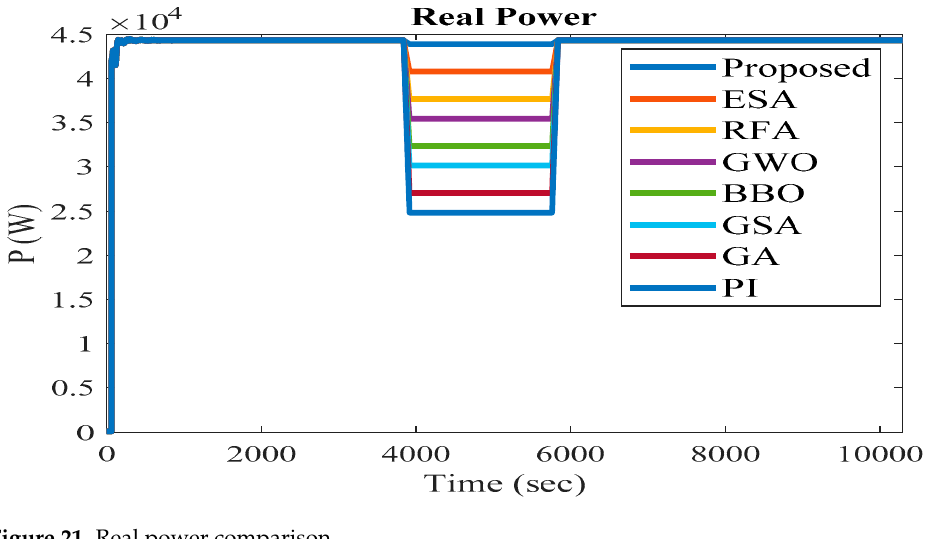
Figure 21. Real power comparison.